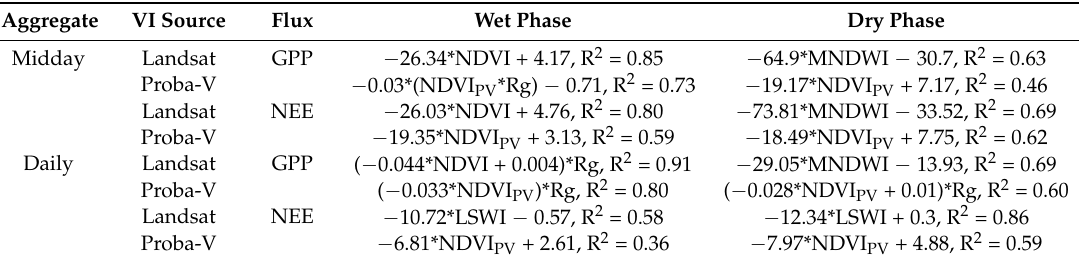
Table 5. Best models selection based on accuracy metrics.